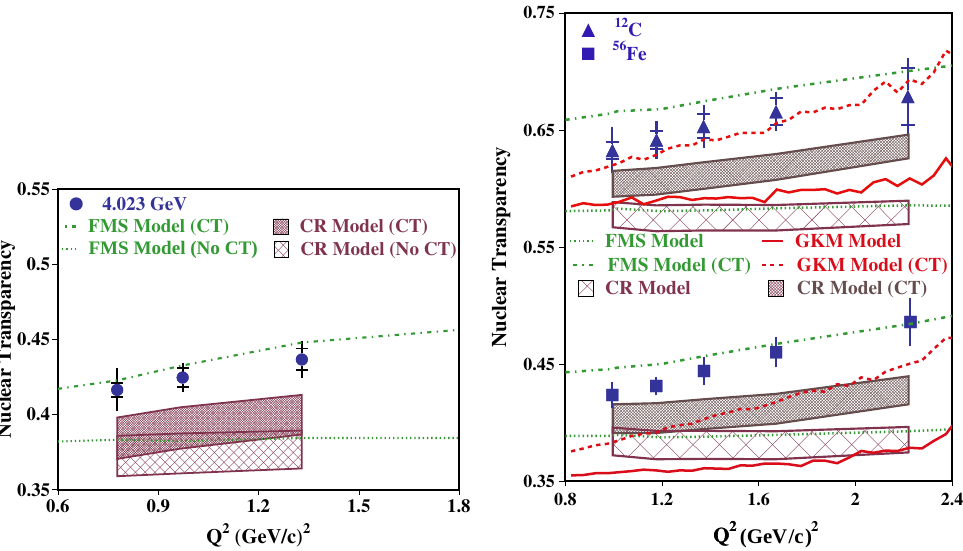
Figure 3. The extracted nuclear transparency for 4 GeV ( left ) and 5 GeV ( right ) iron and carbon data as a function of Q 2 along with the theoretical curves of Frankfurt–Miller–Strikman (FMS) [46] (green), Gallmeiter–Kaskulov–Mosel (GKM) [47] (red), and Cosyn–Ryckebusch (CR) [48] (magenta) models with (dashed and dashed-dotted curves and hatched band, respectively) and without (dotted and dashed-dotted curves and open-square band, respectively) CT. All models include the effect of the ρ 0 decay inside the nucleus. The upper and lower limits of the CR bands are evaluated by varying the decaying pions angles ( π – ρ angles) in the center of mass